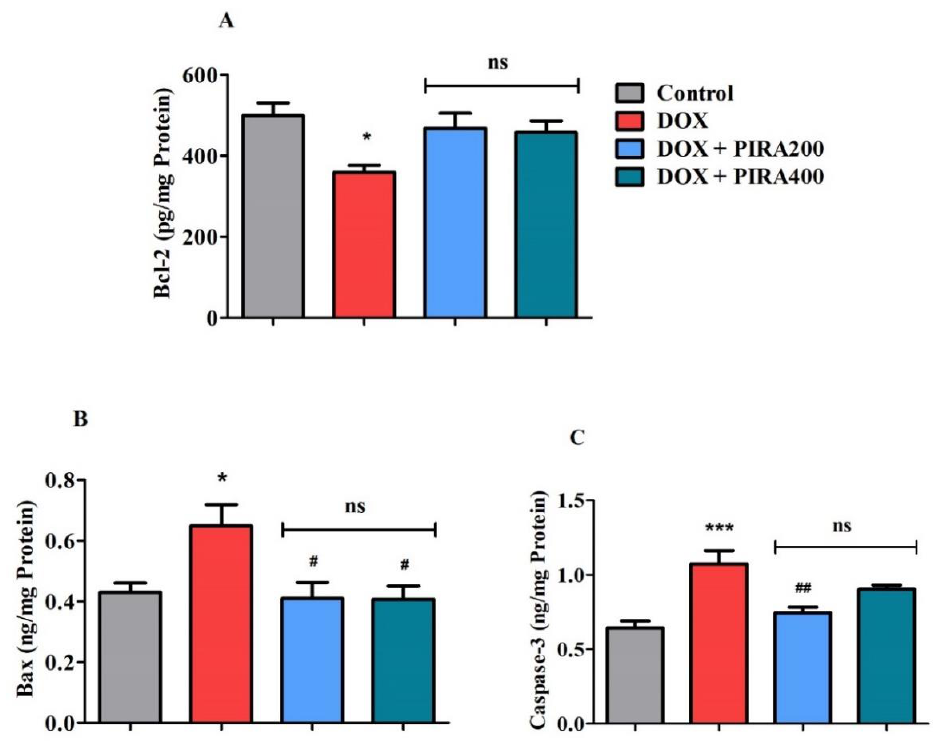
Figure 6. Effect of piracetam (PIRA) on apoptosis parameters ( A ) Bcl-2, ( B ) Bax, and ( C ) caspase-3 in doxorubicin (DOX)-induced rat model. The results are expressed by mean ± SEM ( n = 7). A one-way ANOVA [ F (3,24) = 5.099, p < 0.01 for Bcl-2; F (3,24) = 4.160, p < 0.05 for Bax; F (3,24) = 11.43, p <